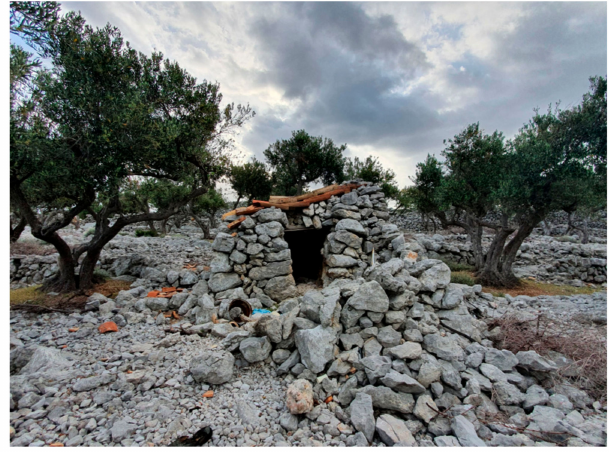
Figure 23. The typical dry stone wall shelter, with a maintained single pitch roof made from tiles, is in the Cres olive grove (Tanja Kremeni´c, 2020).